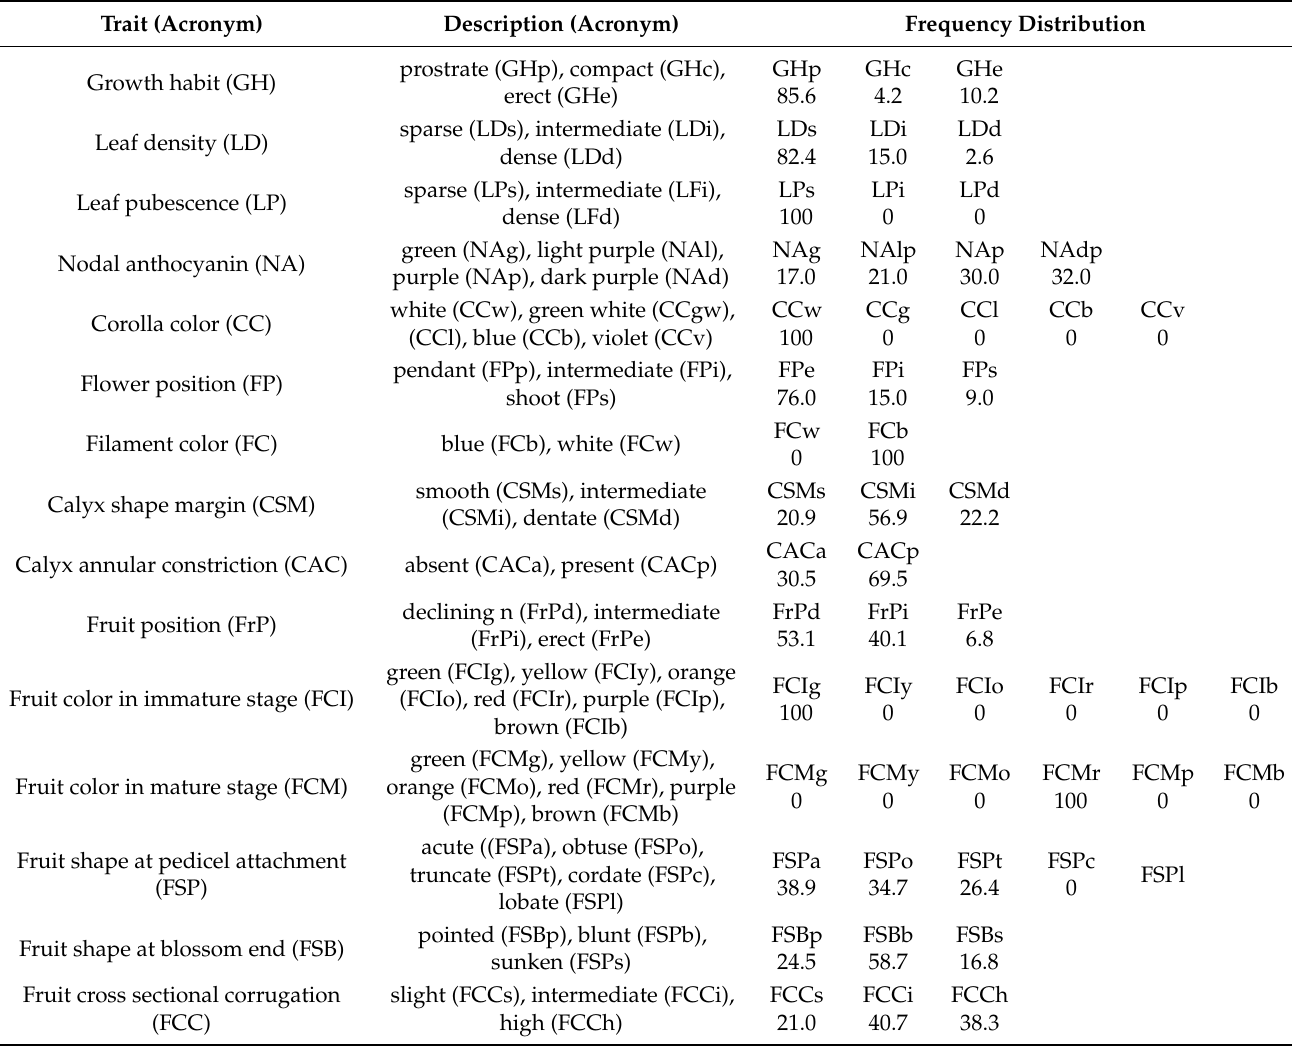
Table 2. Frequency distribution of the 16 descriptive traits among the Tunisian chili pepper accessions under study.